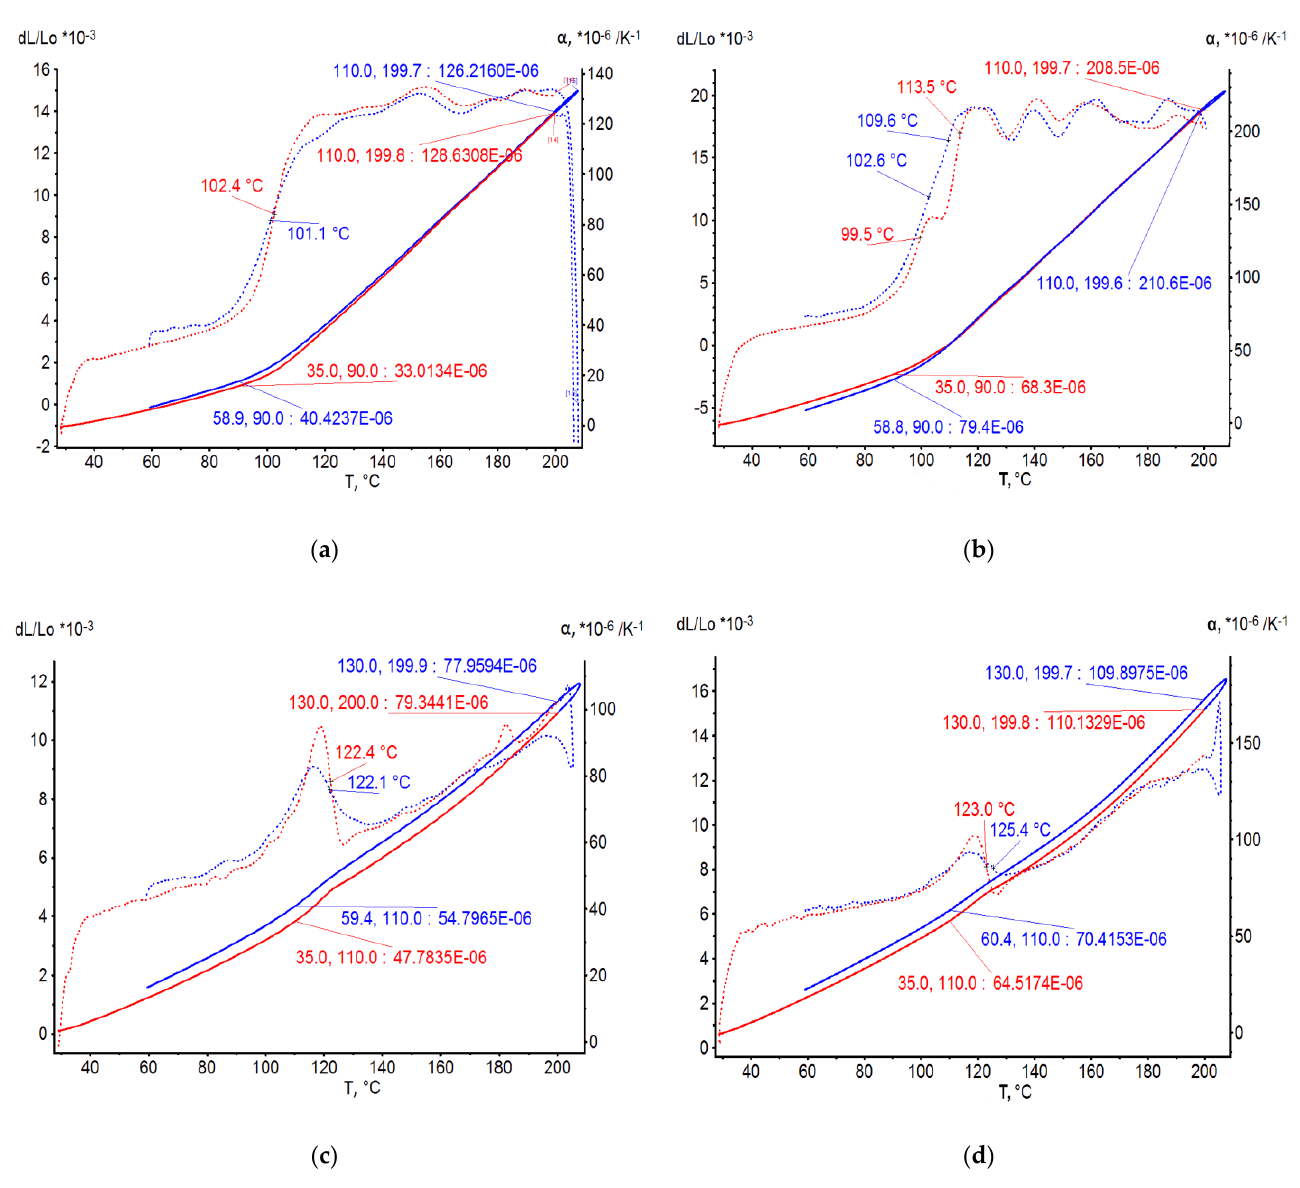
Figure 3. Polymers’ TE curves: ( a ) EP, ( b ) EP+FA, ( c ) EP after T-relax, ( d ) EP+FA after T-relax.